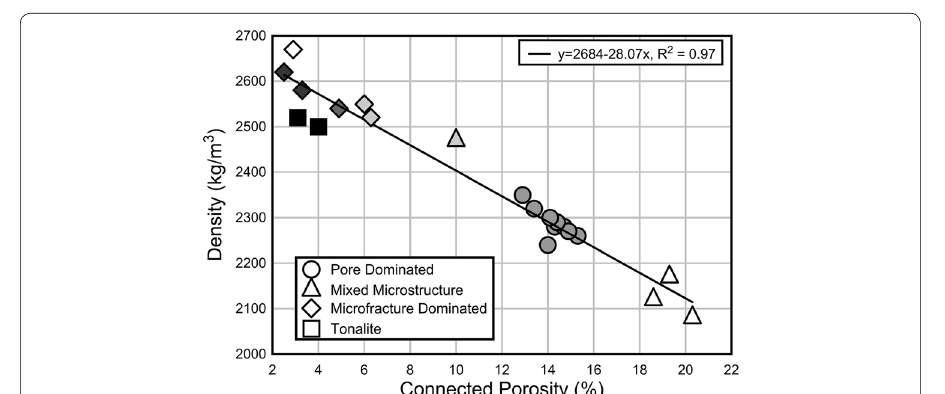
Fig. 8 Dry bulk density versus connected porosity of all samples, by lithology. Tone darkens with depth of sample, as shown in legend in Fig. 7a